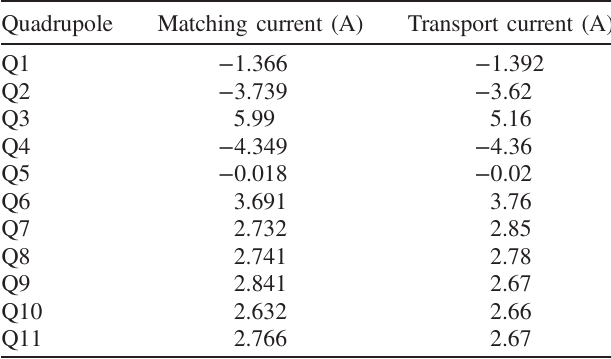
TABLE V. Quadrupoles ’ current settings for two different conditions (matching and transport) used for GENESIS simulation reported in Fig. 7.